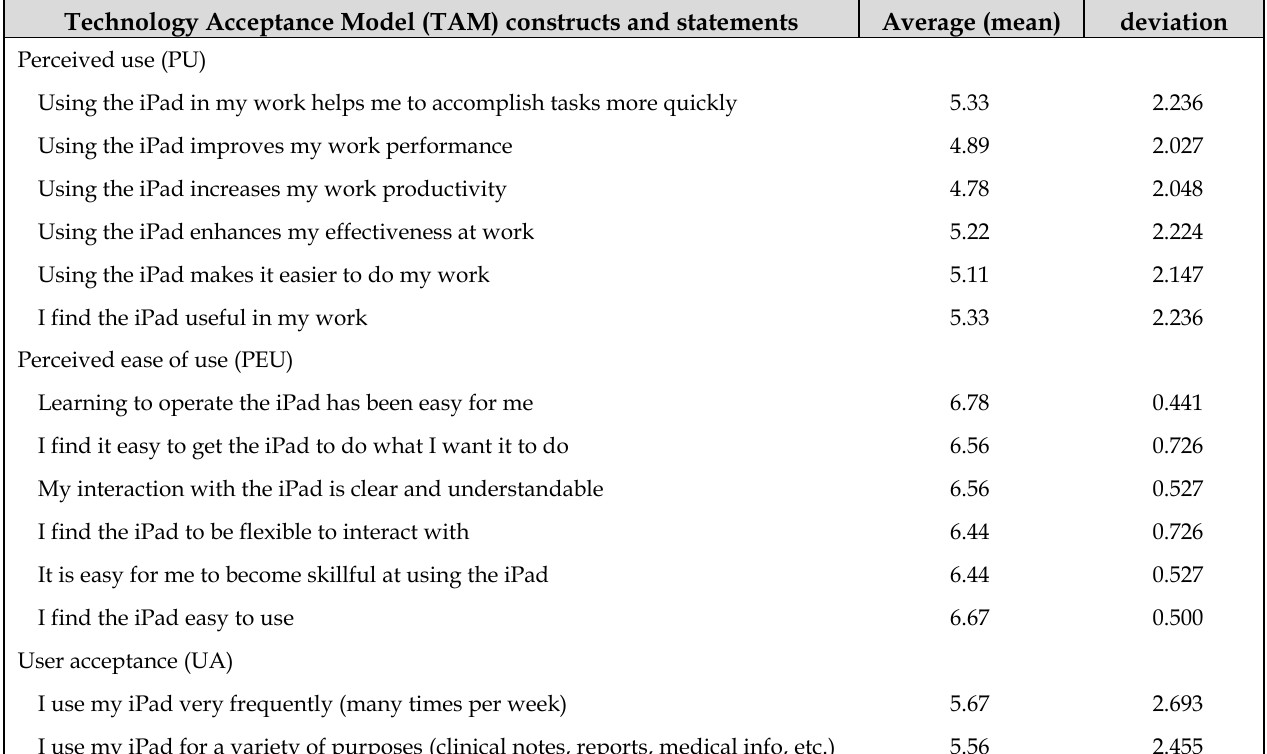
Table 1 Technology acceptance model post-survey scores Technology Acceptance Model (TAM) constructs and statements